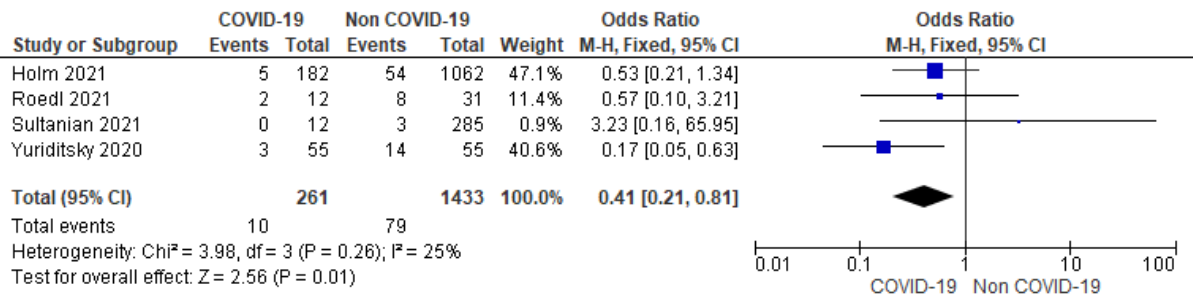
Figure 4. Forest plot showing group di ff erences on TTM use among COVID-19 versus non-COVID- 19 patients using fi xed e ff ect model. [13–15,17].